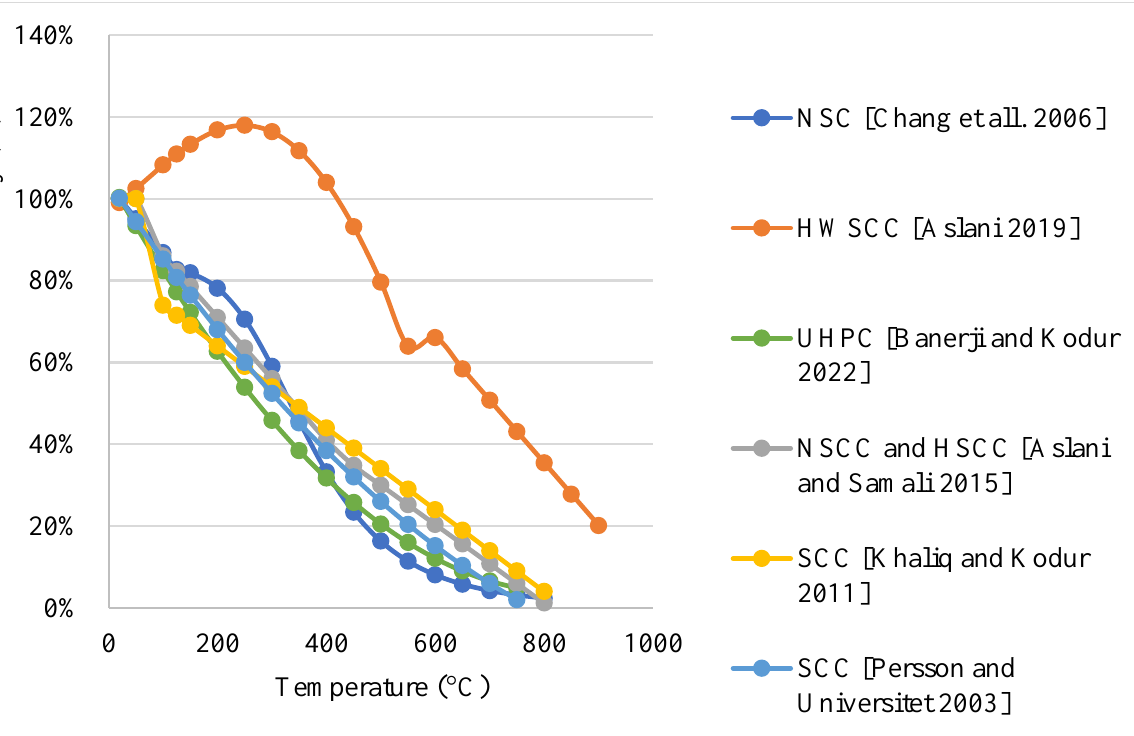
Figure 51. Relative modulus of elasticity models for different types of concrete [48,75,97,100,108,135].